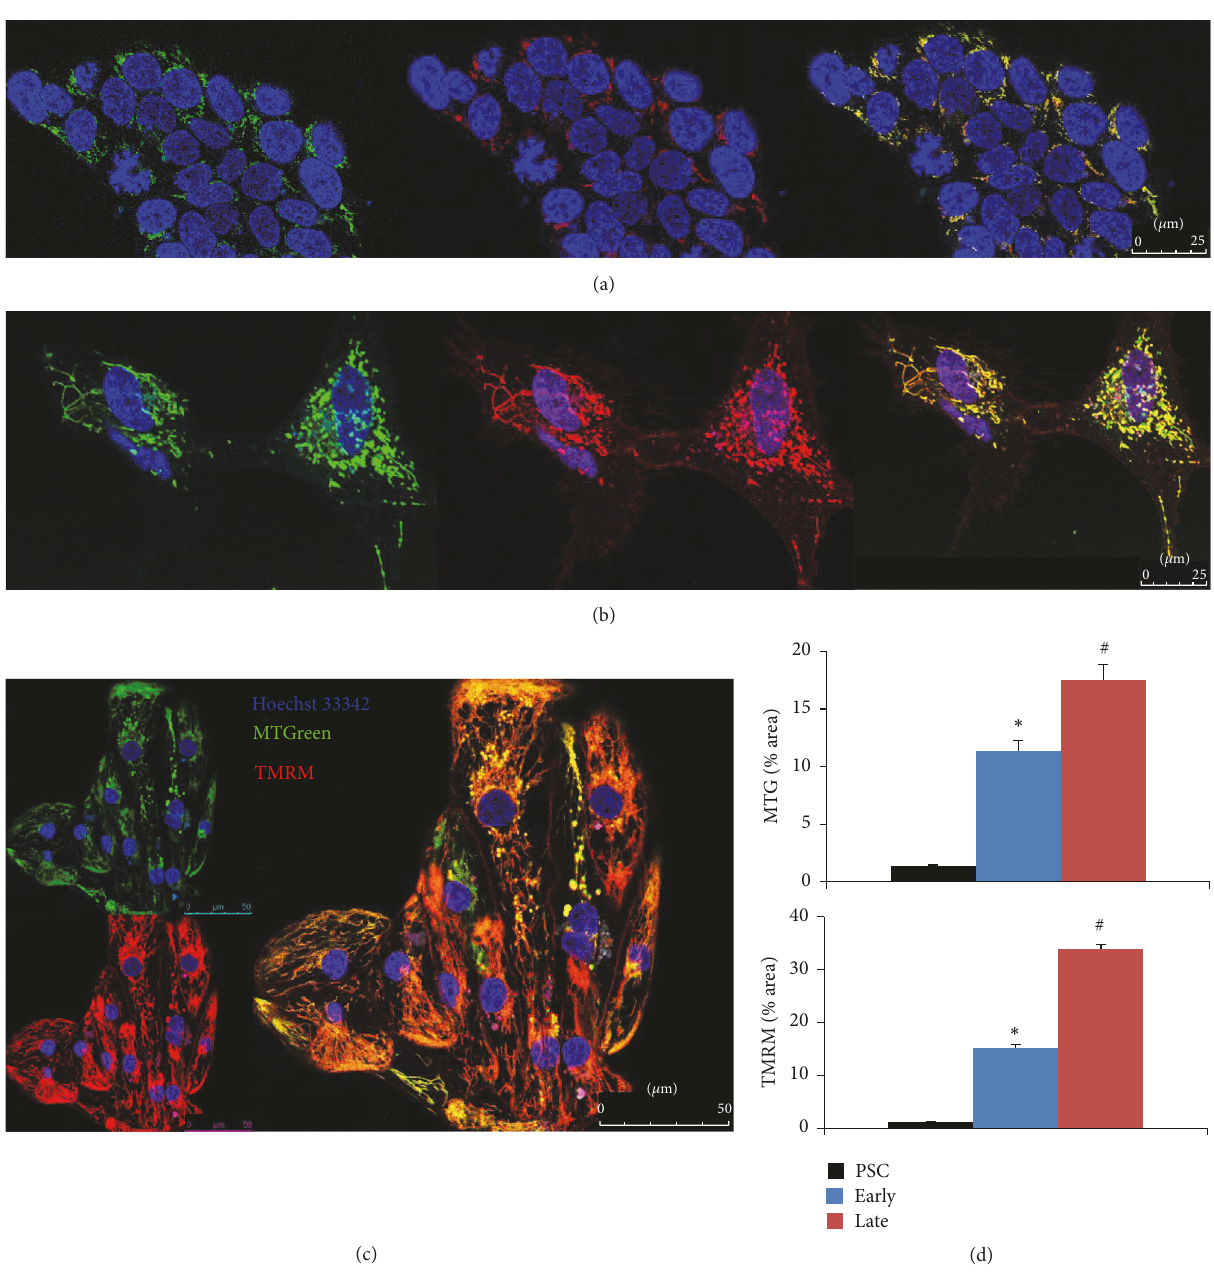
Figure 2: Live staining of representative undifferentiated hPSC (a), early hPSC-CM (b), and late hPSC-CM (c) with MitoTracker Green (MTG), TMRM (red), and Hoechst 33342 (blue) and the overlay images. (d) Quantitative image analysis of relative area of MTG (above) and TMRM (bottom) staining. ∗ 𝑝 < 0.001 compared with PSC, # 𝑝 < 0.001 compared with early stage hPSC-CMs.